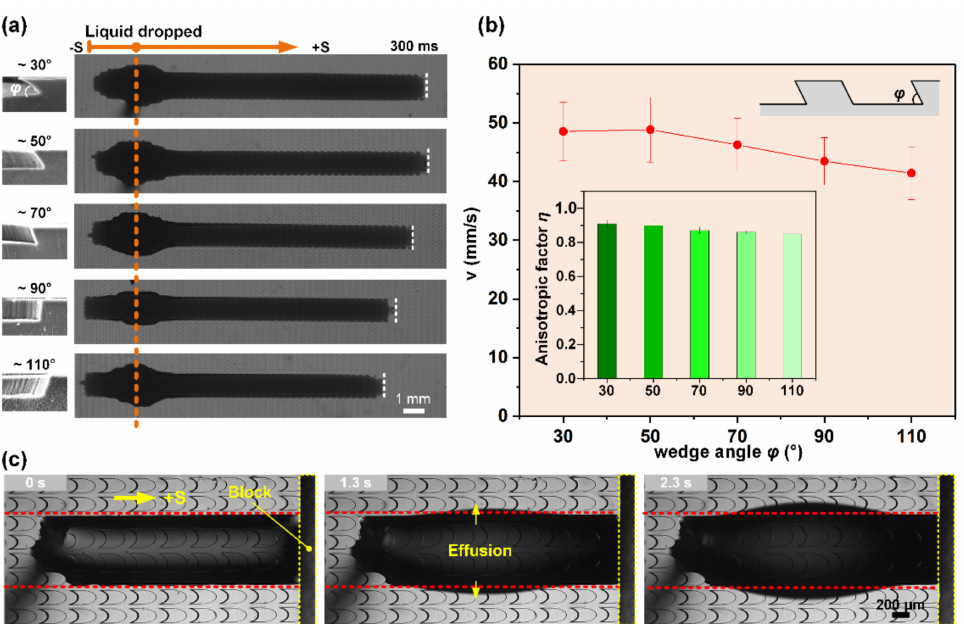
Figure 5. ( a ) In situ observation of STC unidirectional liquid spreading channels with di ff erent wedge angle ranging from about 30 ◦ to 110 ◦ at a time of 300 ms. ( b ) The velocity and anisotropic liquid spreading factor in di ff erent structures. ( c ) Time-lapse images of pinning failure